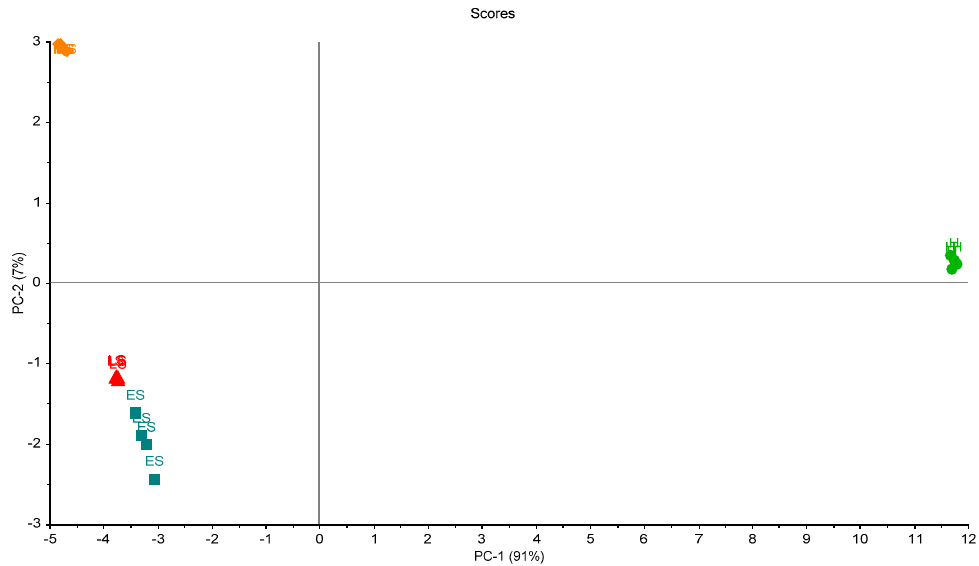
Figure 9. Scores plot of the samples in the third trial of measurements. A clear separation between samples is shown. Healthy sample (H), infected early-stage (ES), infected moderate-stage (MS), and infected late-stage (LS).